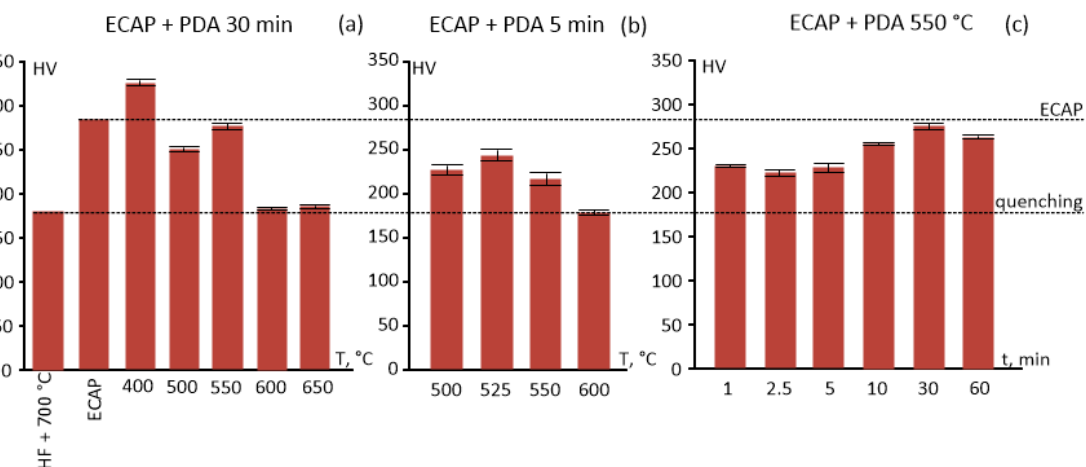
Figure 7. Hardness of the Ti ‐ 18Zr ‐ 15Nb alloy after: ( a ) ECAP + PDA 30 min; ( b ) ECAP + PDA 5 min; ( c ) ECAP + PDA 550 ° С .